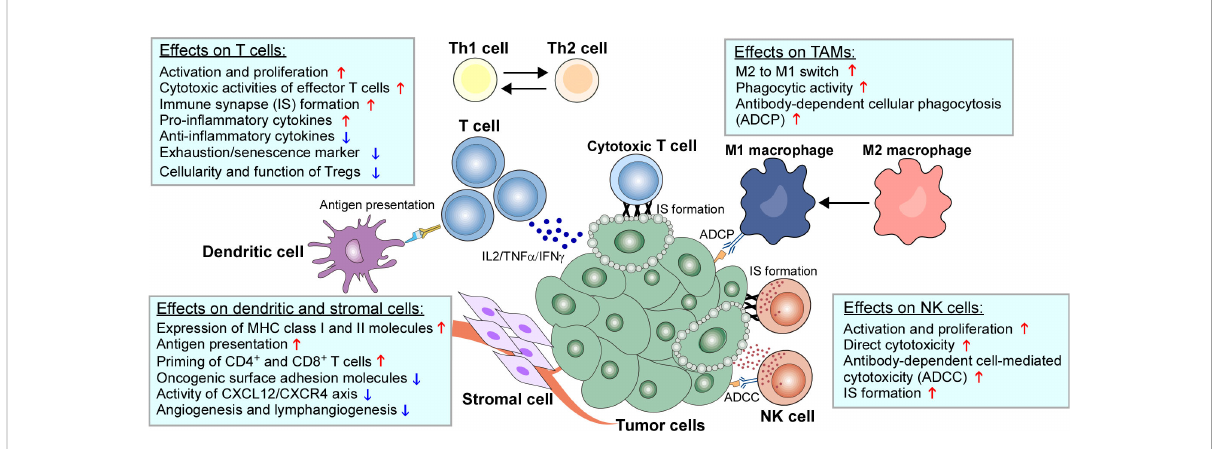
FIGURE 2 Immunomodulatory effects of IMiDs on the TME of B-cell neoplasms. The biological impacts of IMiDs on T cells, natural killer (NK) cells, tumor- associated macrophages (TAMs), dendritic cells and stromal cells are